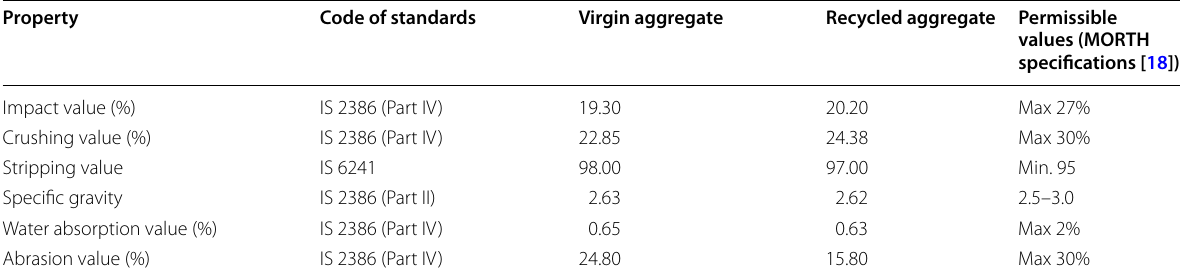
Table 1 Properties of Virgin and Recycled aggregate